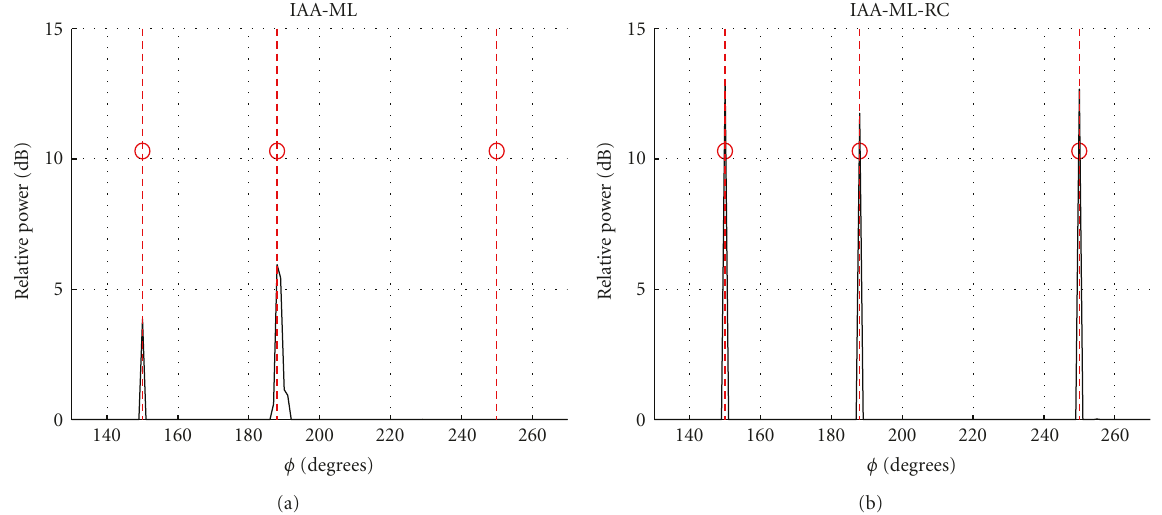
Figure 5: IAA-ML versus IAA-ML-RC comparison (one realization, rectangular array, θ 1 = 45 ◦ , φ 1 = 150 ◦ , θ 2 = 45 ◦ , φ 2 = 188 ◦ , θ 3 = 45 ◦ , φ 3 = 250 ◦ , N = 3 snapshots, SNR 1 = SNR 2 = SNR 3 = 10dB, noise power equal to 0dB, and f c =